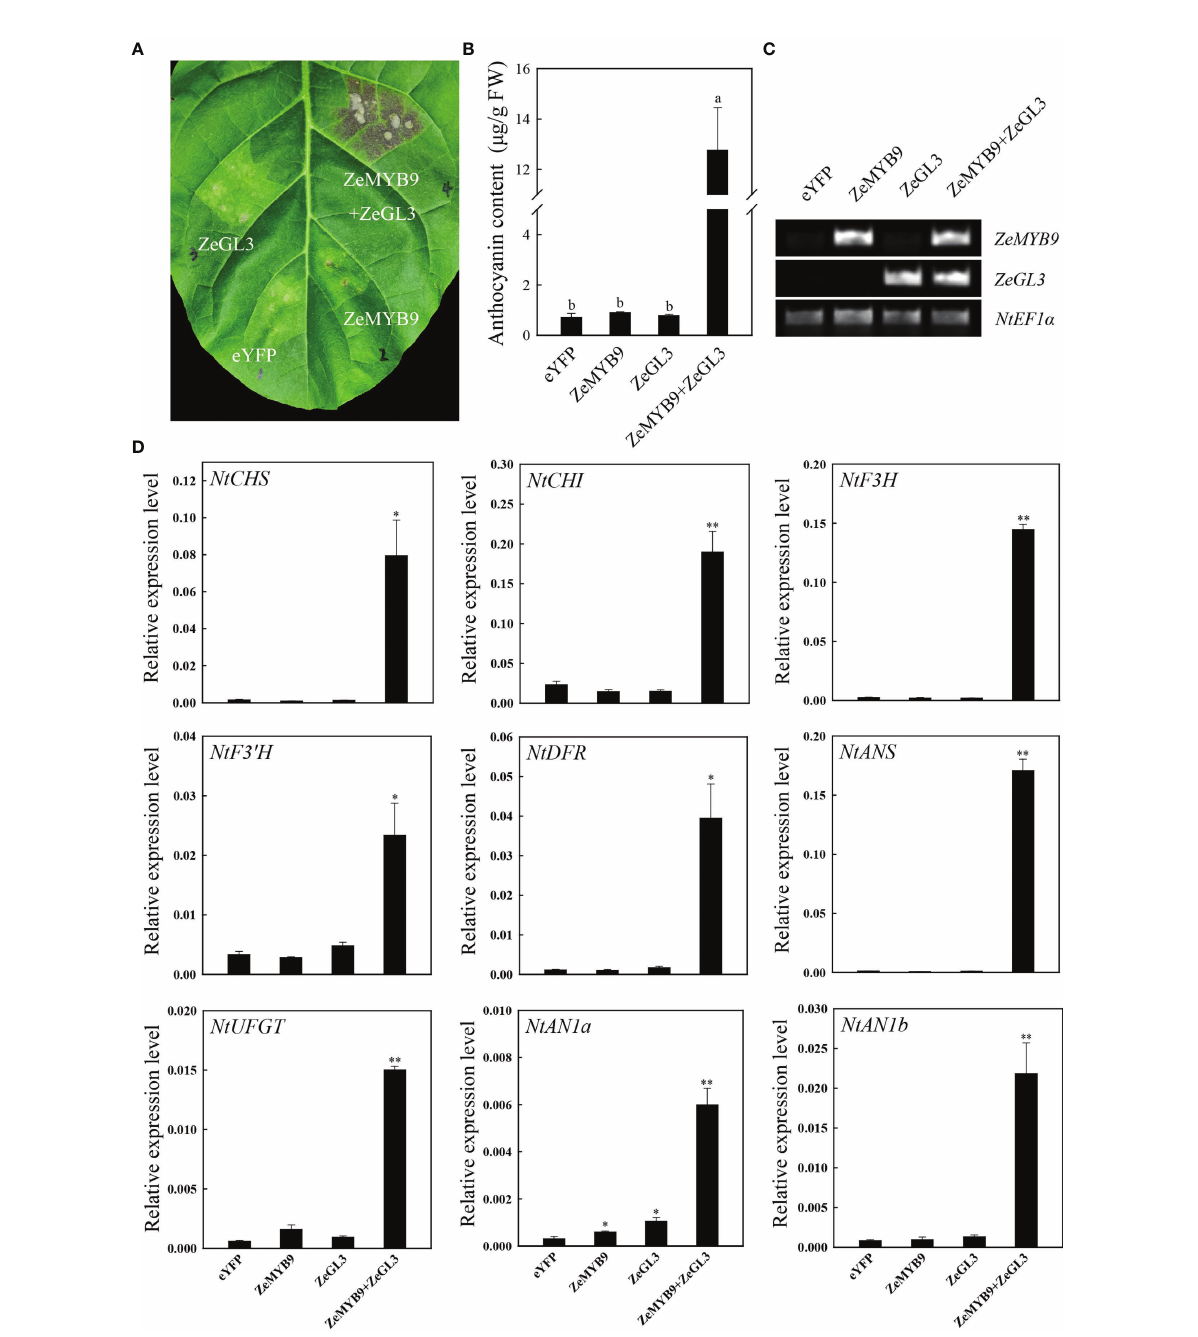
FIGURE 7 Co-expression of ZeMYB9 and ZeGL3 induces anthocyanin accumulation in tobacco leaves. (A) The tobacco leaves were photographed by camera and the location of gene injection was indicated on the graph. (B) Analysis of total anthocyanin content. Error bars indicate standard error (SE). And different lowercases indicate signi fi cant differences ( P < 0.05). (C) Transcription levels of ZeMYB9 and ZeGL3 in the control and transient transformation of tobacco. NtEF1 a was used as the reference gene. (D) Relative expression levels of the anthocyanin biosynthesis related structural genes and bHLHs ( AN1a and AN1b ). NtEF1 a gene was used as an internal control for normalization, and three biological replicates were performed for qRT-PCR analysis. T-test was used for statistical analyses compared with corresponding control (* P < 0.05, ** P <